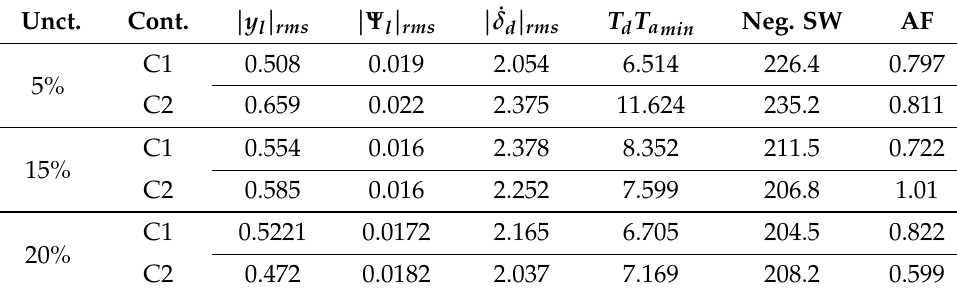
Table 2. Influence of uncertainties on controller performance. Unct.